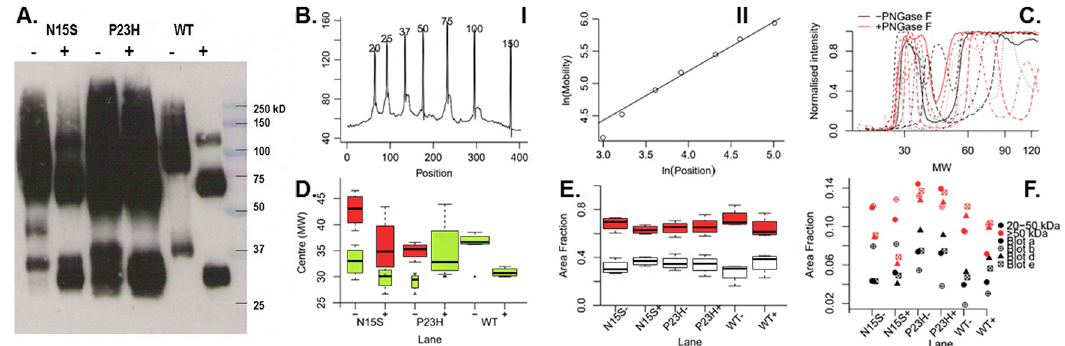
Fig 3. Deglycosylation analysis of rhodopsin. A. Example blot with rhodopsin mutation (N15S, P23H and WT transiently in COS- 1 cells), and PNGase F treatment (+/-) by lane indicated. Protein concentrations were adjusted according to expression level and approximately 1 μ g was loaded. B. Use of the ladder to obtain molecular weights for mobility values for the blot shown in A. (I) Peak picking was performed automatically by selecting the local maxima. (II) Linear regression performed on ln(MW) and ln(Position). This was then rearranged so molecular weights could be estimated for each pixel. C. Density profiles aligned by the process in B. for WT rhodopsin. Black and red lines show profiles before and after PNGase F treatment respectively. D. Boxplots of centres of peaks fitted to profiles (e.g. C.). Box widths are proportional to the relative area occupied by that peak in the region from 20 to 50 kDa. E. Boxplots of the area fraction of density profiles separated by lane from numerical integration between 20 and 50kDa ( white ) and above 50kDa ( red ). F. Scatterplot of the area fraction of the density profiles of all lanes in a gel from numerical integration of the categories as in